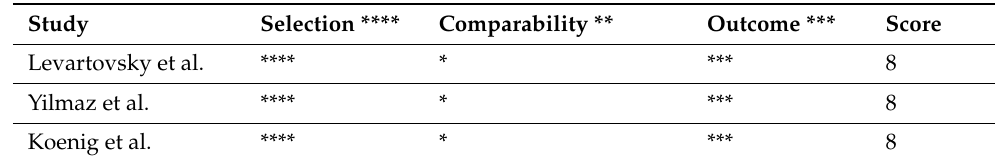
Table 2. Quality of included studies using Newcastle–Ottawa scale (NOS). Studies that met five or more of the NOS score criteria were considered as good quality (the number of * indicate the maximum score of each column accordingly to NOS